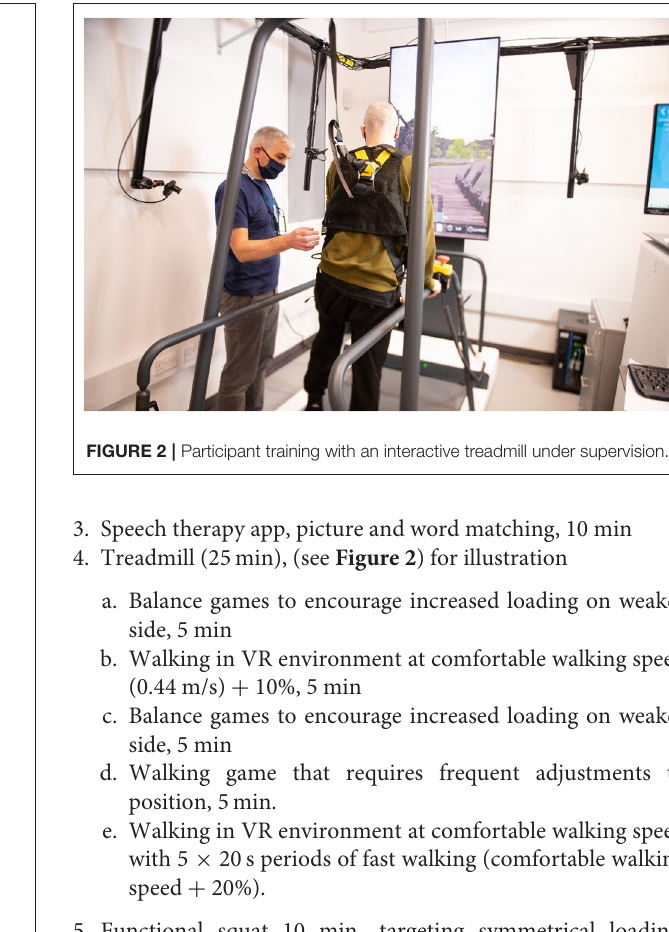
FIGURE 1 | Flow of participants through centre.